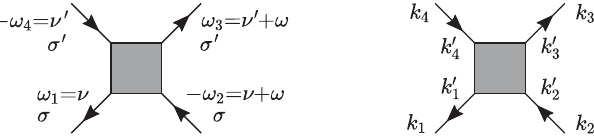
FIG. 5. Diagrammatic representation labeling the external legs of a 4p function. The left-hand panel gives frequency and spin labels; one label per line suffices as the propagator is diagonal in spin and has only one independent frequency. The right-hand panel additionally shows two Keldysh indices per